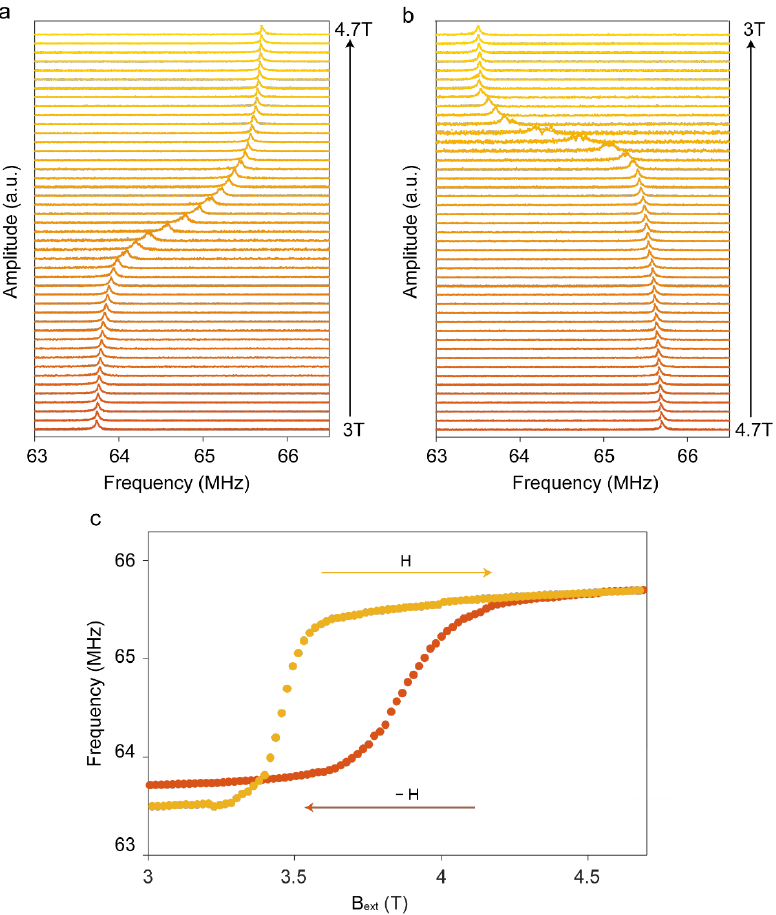
Figure 3. Mechanical resonance of the CrOCl resonators versus perpendicular magnetic field. ( a ) Mechanical resonance curves with the external magnetic field sweeping from 3 T to 4.7 T, and a reversed scan from 4.7 T to 3 T shown in ( b ). ( c ) Resonant frequency f 0 of CrOCl resonators as a function of perpendicular magnetic field revealed from the fittings of ( a , b ). The curves with yellow and red color represent forward and reverse sweeping respectively.